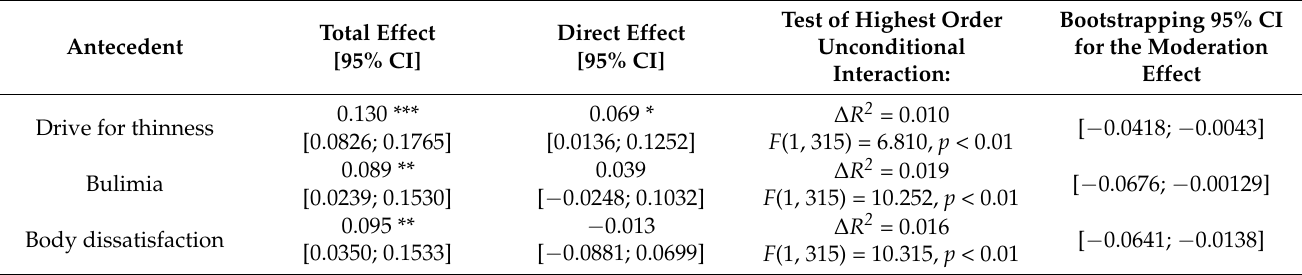
Table 3. Summaries of the